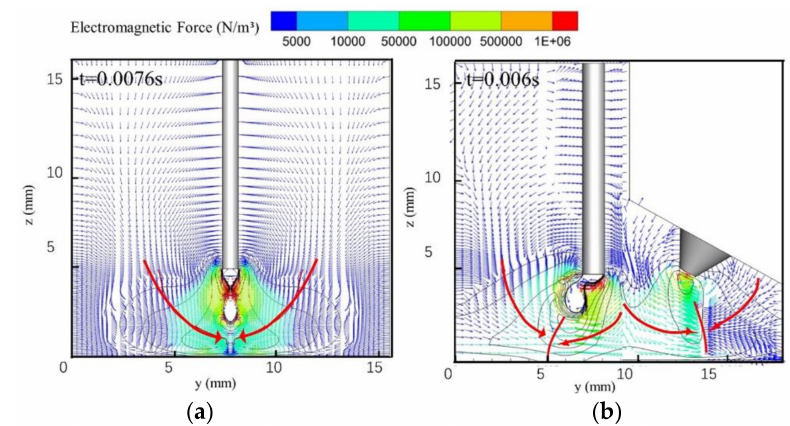
Figure 8. Distribution of electromagnetic force in the arc: ( a ) MIG; ( b ) TIG-MIG.